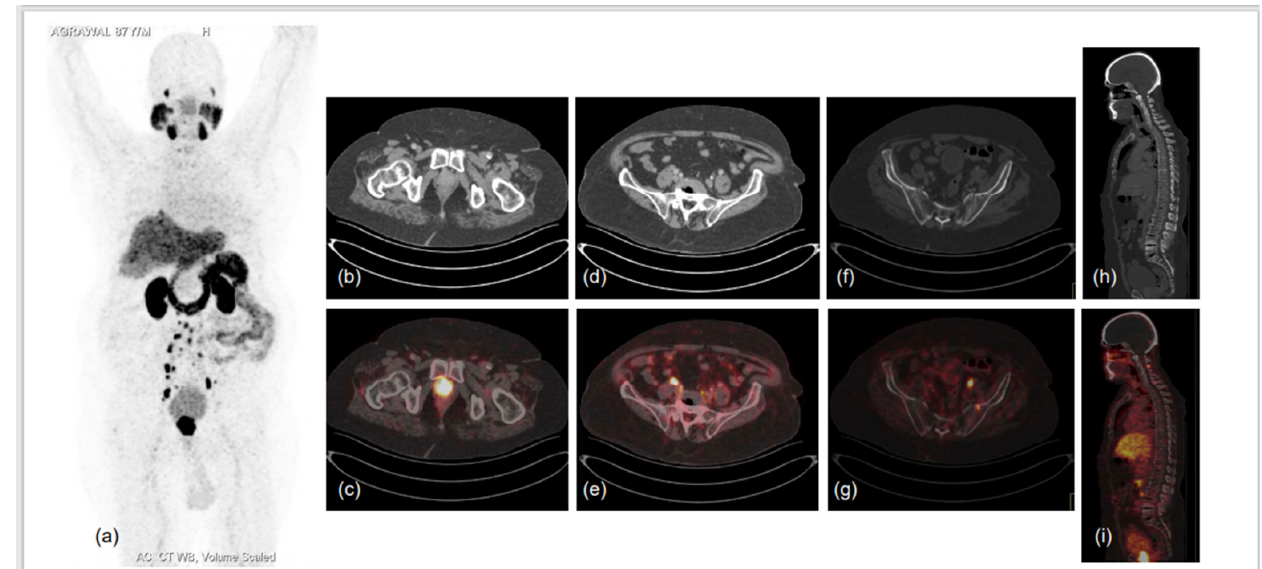
Figure 3. 87-year-old male diagnosed with adenocarcinoma of prostate (Gleason score 7) in 2017 was heavily pre-treated: ADT with Pamorelin + Bicalutamide followed by Abiraterone and Enzalutamide. Nadir PSA was 0.016 ng/mL during the treatment and biochemical progression was observed for 6 months following. He presented to the doctor’s office with shortness of breath, limp legs, weakness and leg pain, his serum PSA was 94.7 ng/mL, and he was referred for PSMA PET CT scan. 68 Ga-PSMA-11 PET CT scan showed prostatomegaly invading the urinary bladder wall with PSMA expressing irregular enhancing SOL involving almost entire gland. PSMA expressing multiple metastatic pelvic and retroperitoneal lymph nodes and PSMA expressing multiple sclerotic metastatic skeletal lesions showed disease progression as compared to previous PSMA PET-CT scan of 2019. ( a )-MIP image, ( b – i )-CT and fused PET-CT trans-axial and sagittal images. Various studies have reported detection rates ranging from 75% to 90% [45–47].